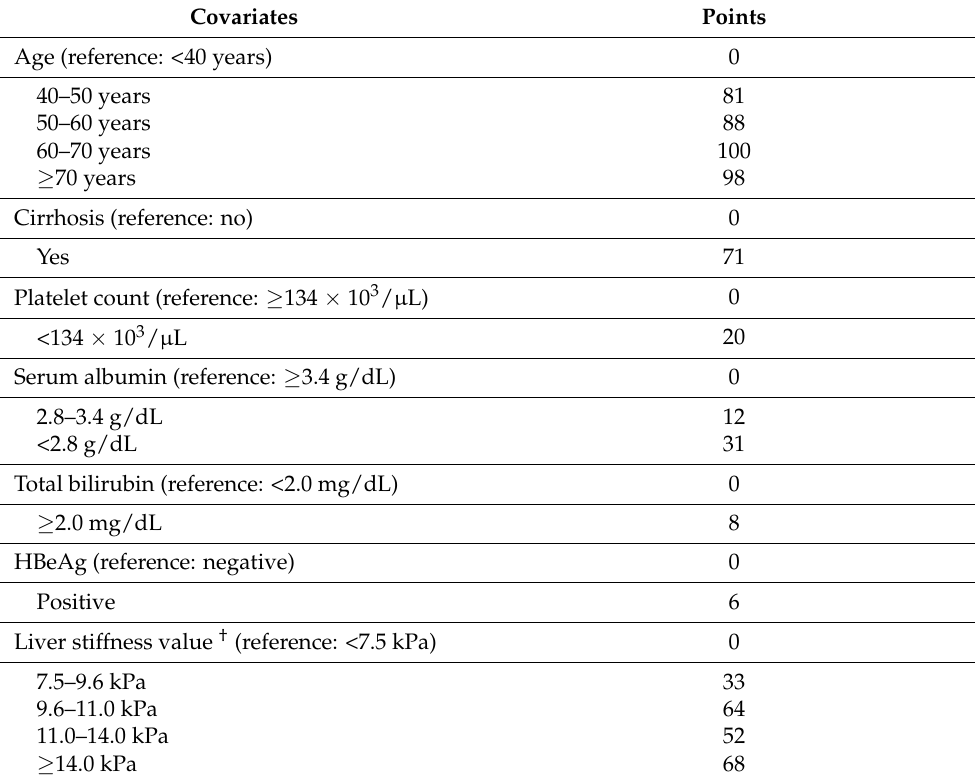
Table 3. Novel nomogram for risk prediction of hepatocellular carcinoma development. Covariates